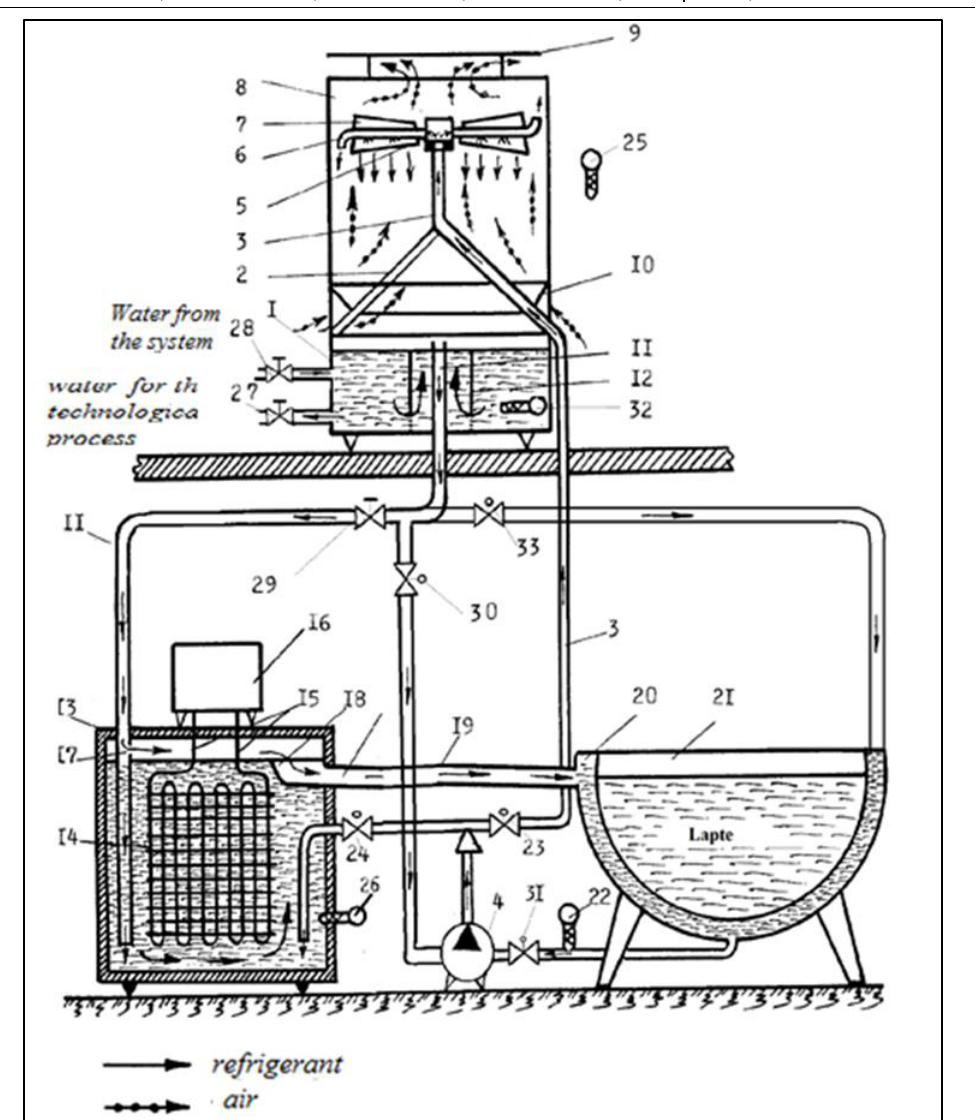
Figure 3. Refrigeration installation and water accumulator for milk chilling in the capacitive cooler by using natural and artificial cooling